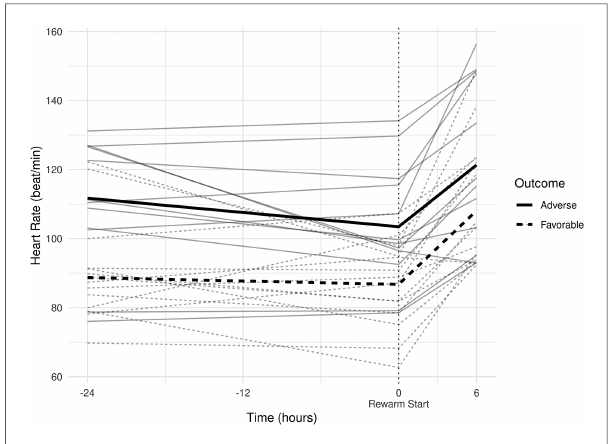
FIGURE 6 Estimated individual stroke volume regression lines and group-level averages of graphs.